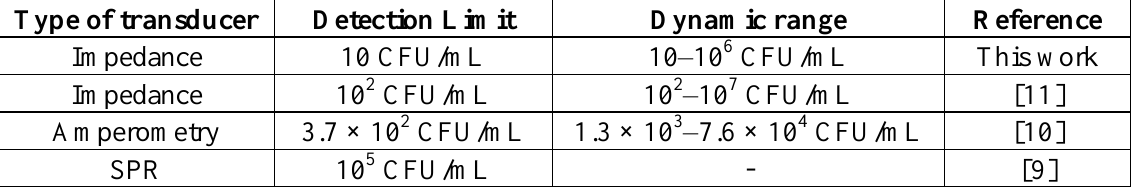
Table 1. A comparison of the analytical characteristics of the immunosensor developed in this work with relevant immunosensors for S. aureus bacteria detection based in the